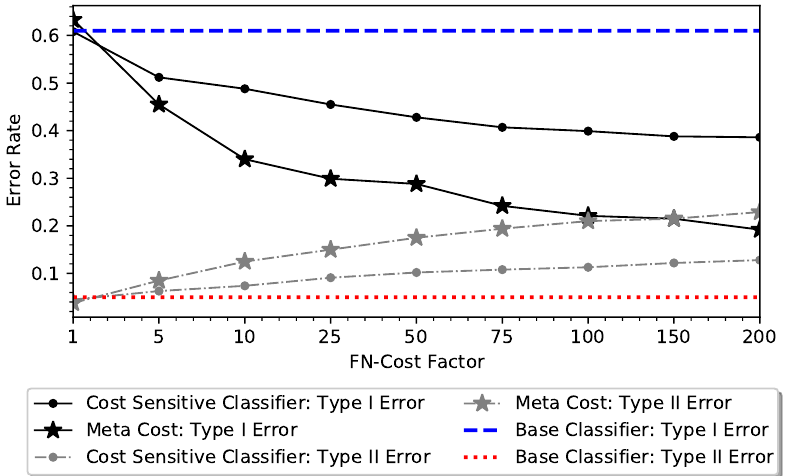
Figure 4. The effect of Adjusting FN-Cost Factor on Type I and Type II Errors.